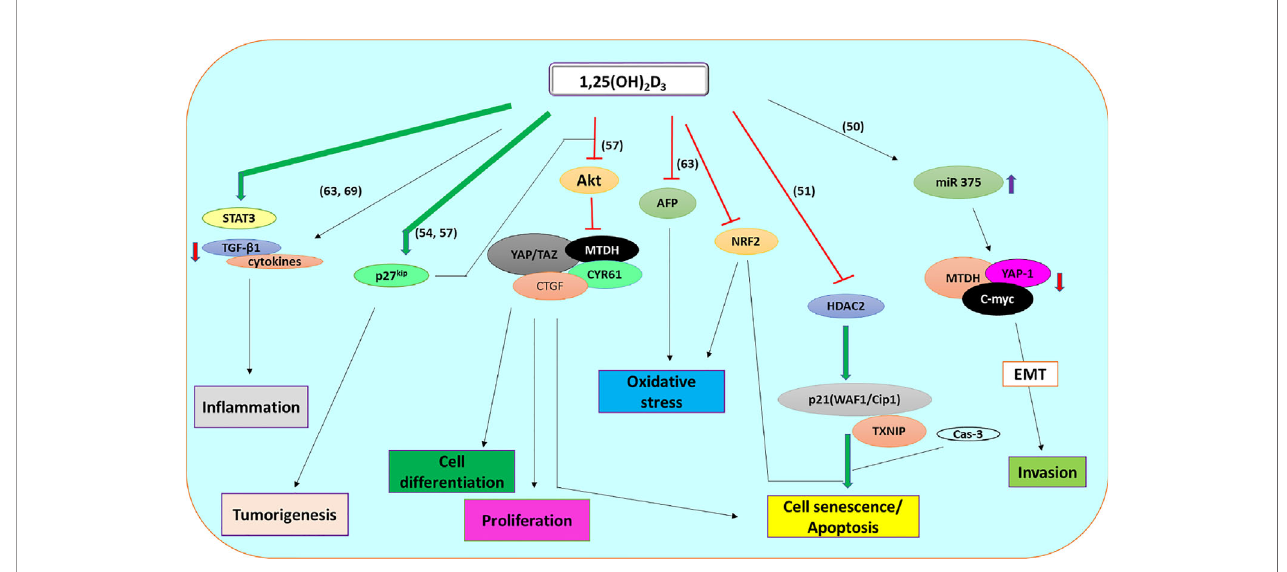
FIGURE 1 | l,25 (OH) 2 D 3 signaling pathway involved in the regulation of HCC through apoptosis, invasion, proliferation, differentiation, tumorigenesis, oxidative stress, and in fl